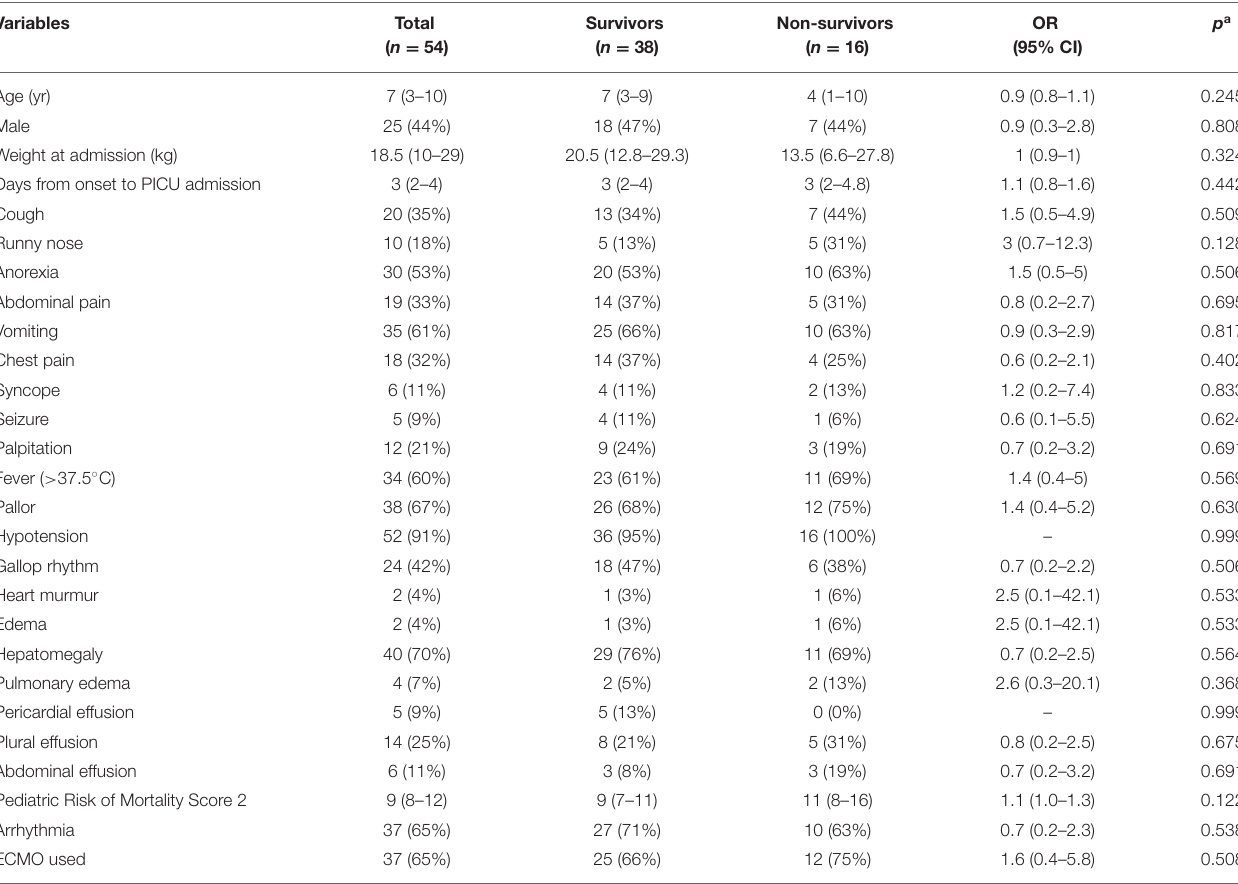
TABLE 1 | Comparison between survivors and non-survivors in terms of demographics, symptoms, and signs at the pediatric intensive care unit